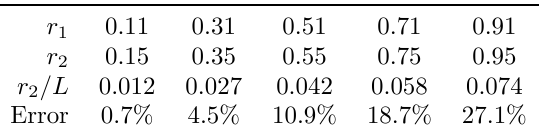
Table 1. The error of Bernoulli beam formulation to the Timoshenko reference solution for di ff erent cross-